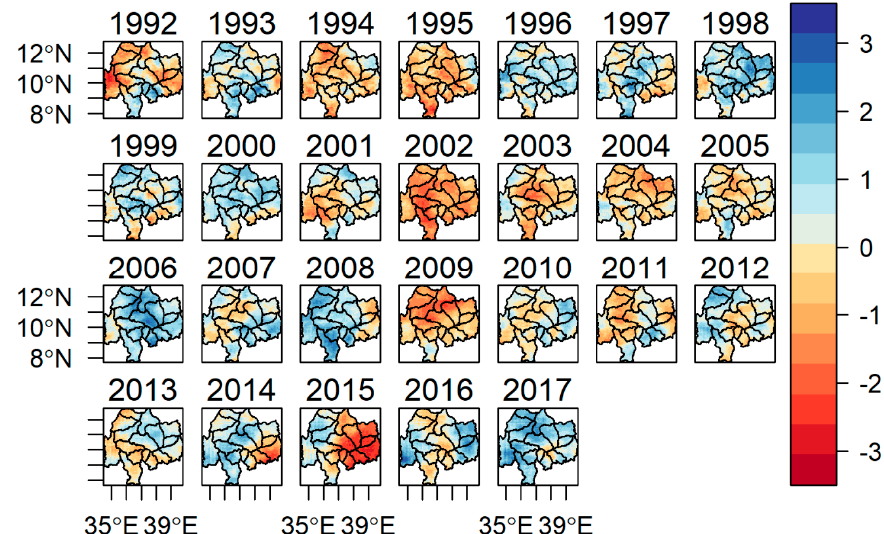
Figure 7. The spatial distribution of mean annual rainfall (mm) over the Upper Blue Nile Basin (UBNB) in Ethiopia (1992 to 2017).